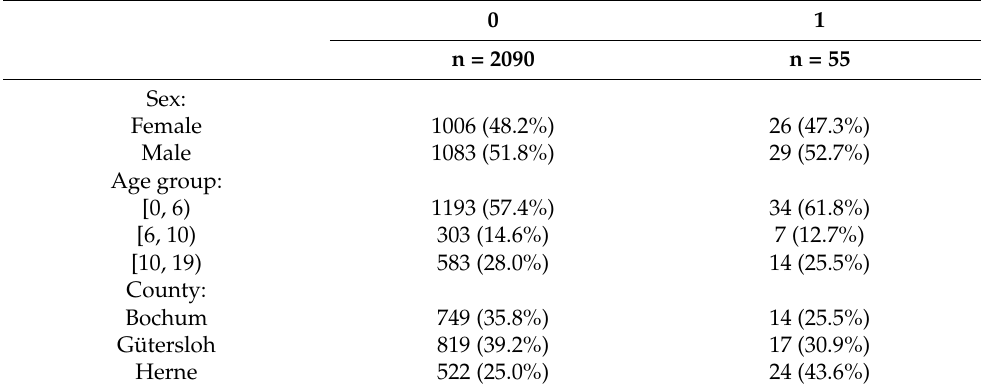
Table 1. Summary descriptive table by groups of seropositivity (missing data are not